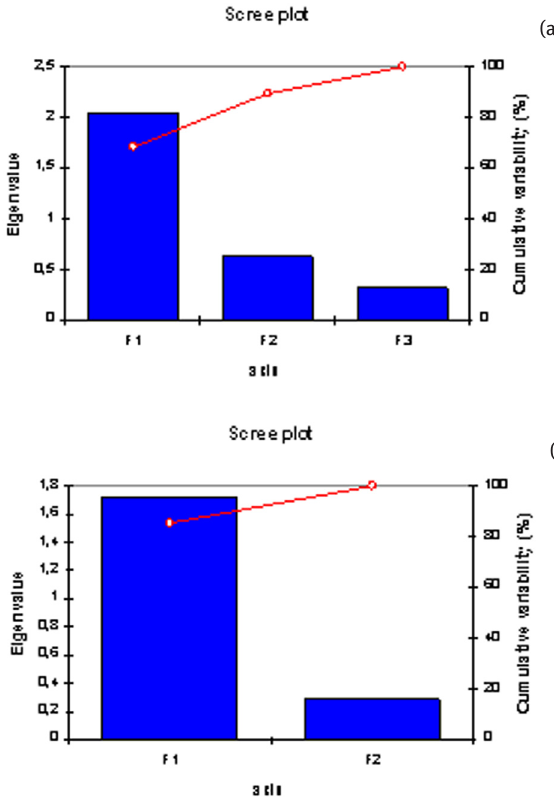
Figure 2: The plot shows the importance of factors and values of cumulative variability - a) data related to concentrations of Fe, Pb, and Zn in soil samples depending on the distance from the road; b) data related to the concentrations of metals in the soil and grape samples.